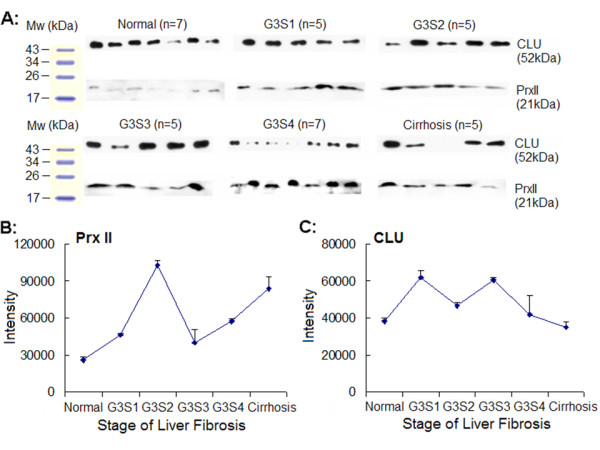
Protein expressions of Prx II and CLU in plasma by Western blot analysis. A: Single samples of normal and liver fibrosis. Immunoblotting with Prx II or CLU polyclonal antibody following SDS-PAGE was performed as described in Section 2.7. The films were scanned and the OD of each band in the film was evaluated by QuantitiOne software. B: The change of Prx II expression is similar to DIGE result (Figure 2.B). C: The change of CLU expression is similar to DIGE result (Figure 3.B).